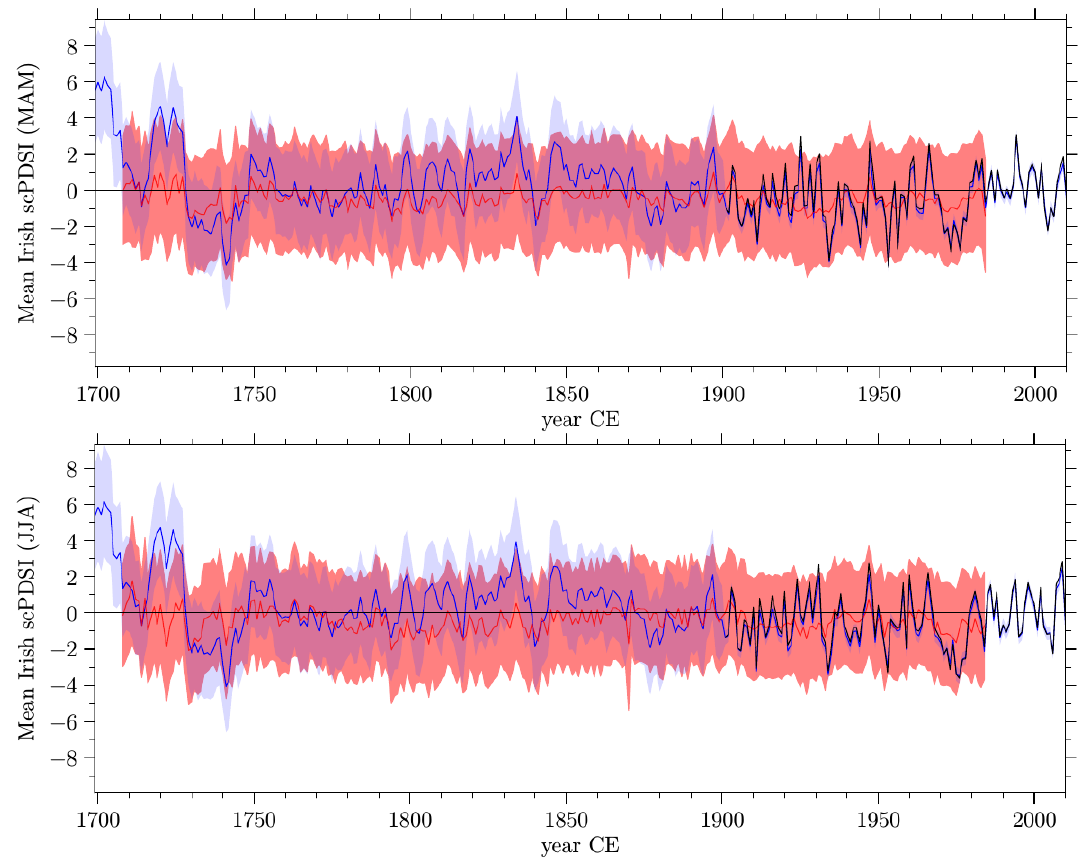
Figure A2. Ireland wide averaged seasonal scPDSI for spring (MAM, top row ) and summer (JJA, bottom row ) using two different methods: BARCAST (blue) and direct linear regression (red) with uncertainties (90%, shaded) and instrumental data (black line). The scPDSI of MAM and JJA is very similar (both instrumental data and reconstruction).